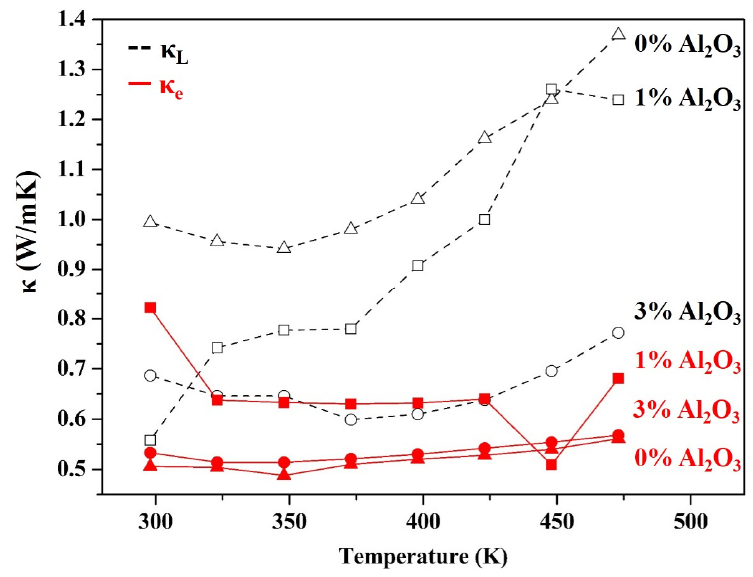
Figure 8. Temperature dependence of lattice thermal conductivity ( κ l ) and electronic thermal conductivity ( κ e ) for the γ -Al 2 O 3 /Bi 0.4 Sb 1.6 Te 3 bulk samples.